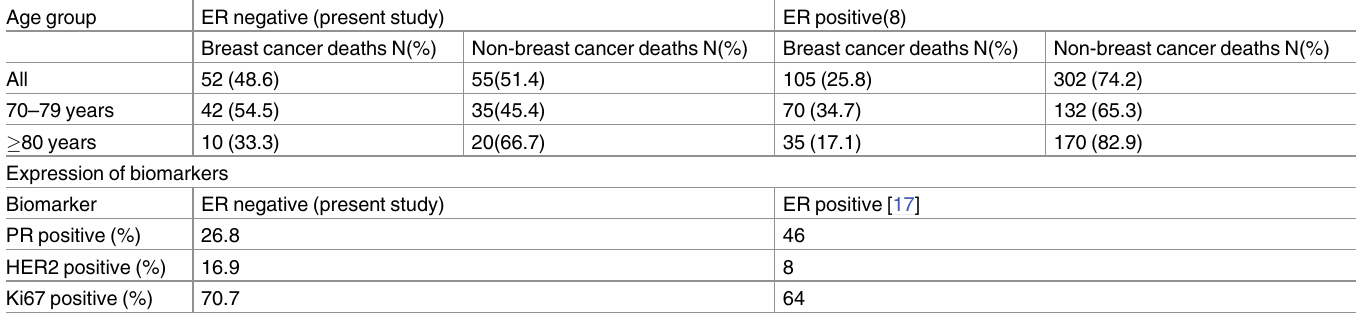
Table 5. Clinical outcome and expression of biomarkers in ER-negative versus ER-positive tumours in older women with early operable primary breast